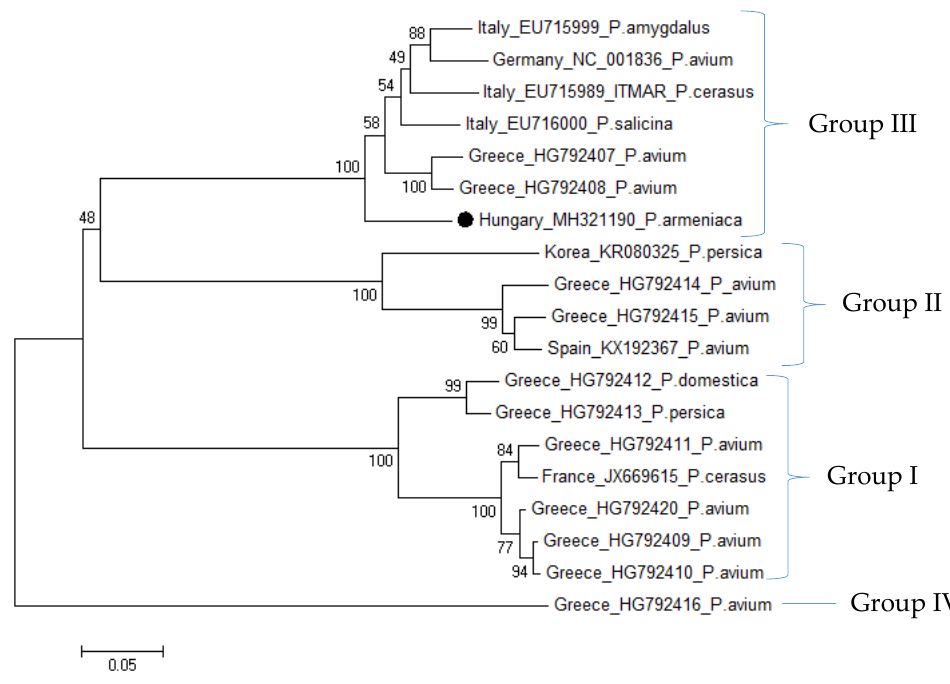
Figure 4. Phylogenetic analysis of the CP coding region of LChV-1 sequences. • -Sequence from Hungarian apricot. Bootstrap values are indicated as